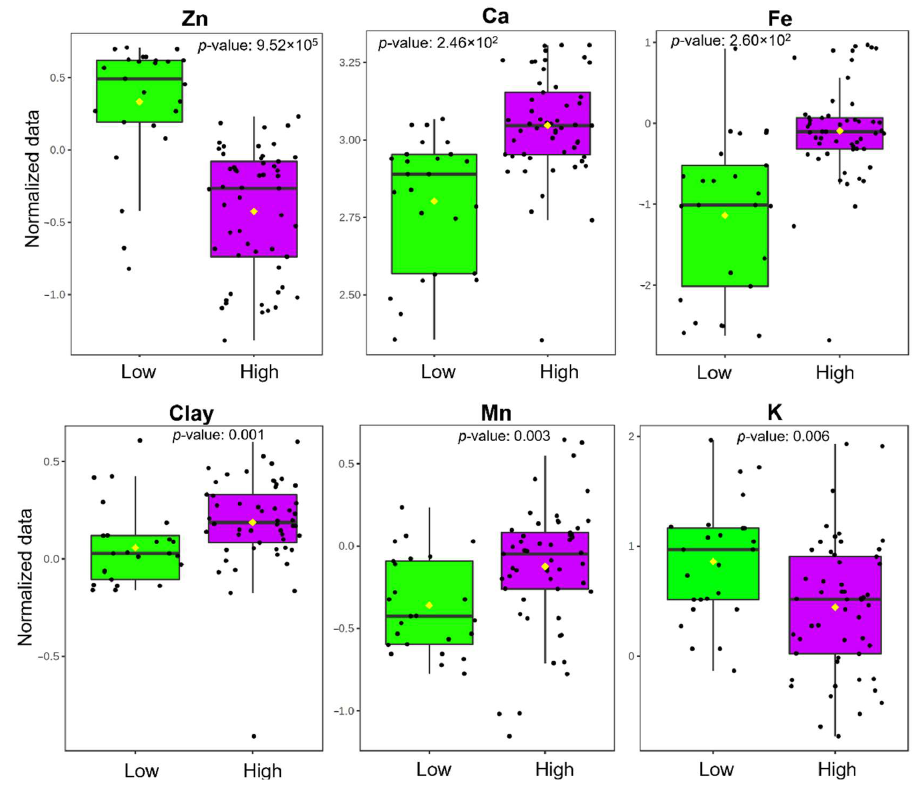
Figure 4. Box plots of levels of soil variables showing significant differences between low and high BW incidence based on the Wilcoxon’s test. Table 1. Important variables selected by Wilcoxon Rank Test with threshold 0.05.